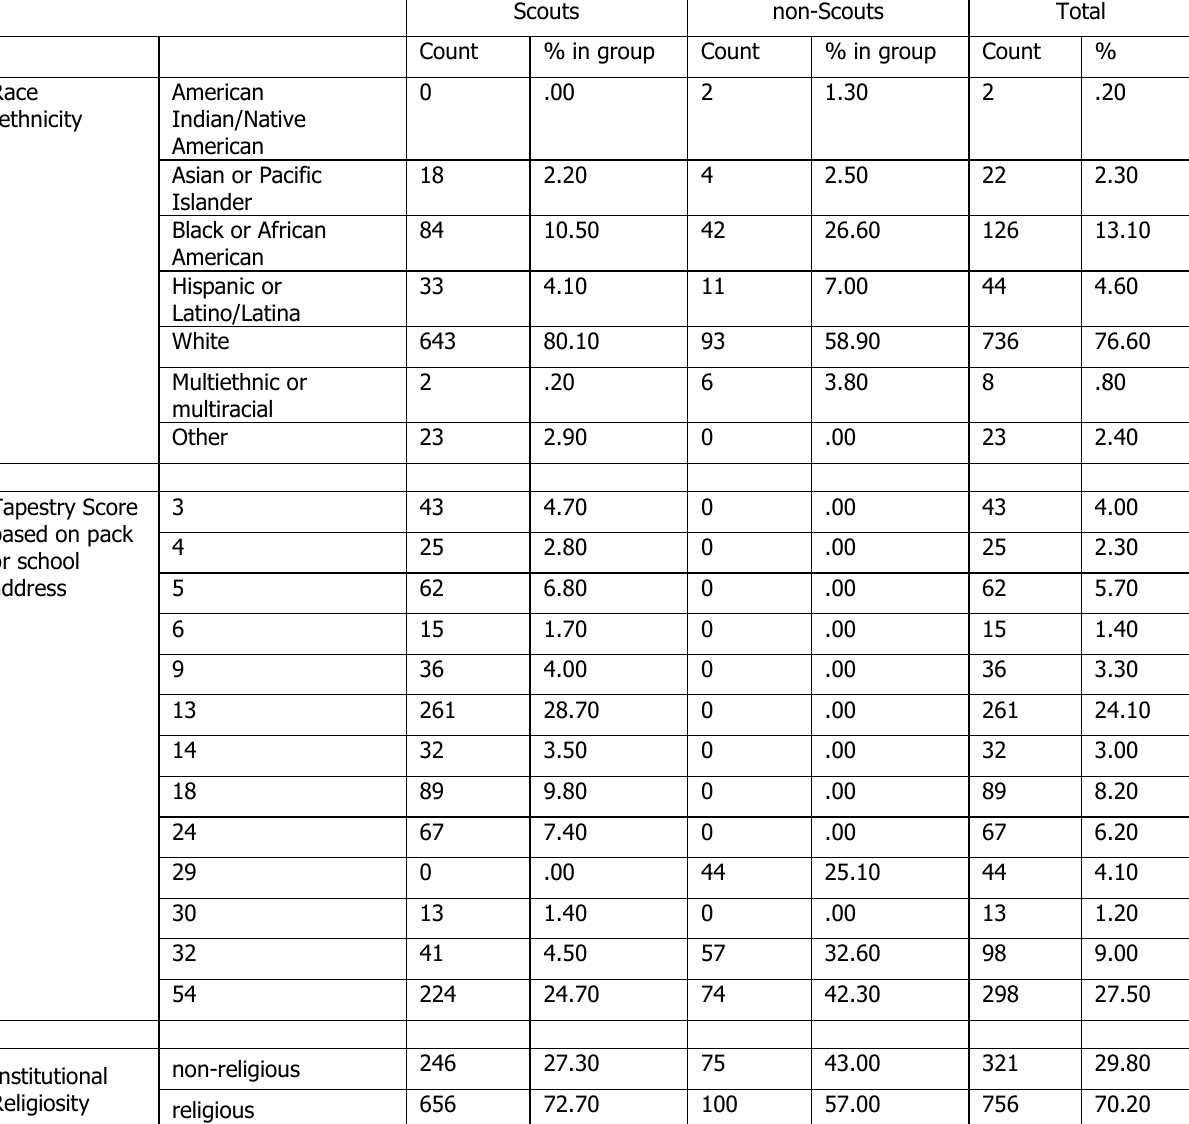
Demographic Information about Scout and non-Scout Participants